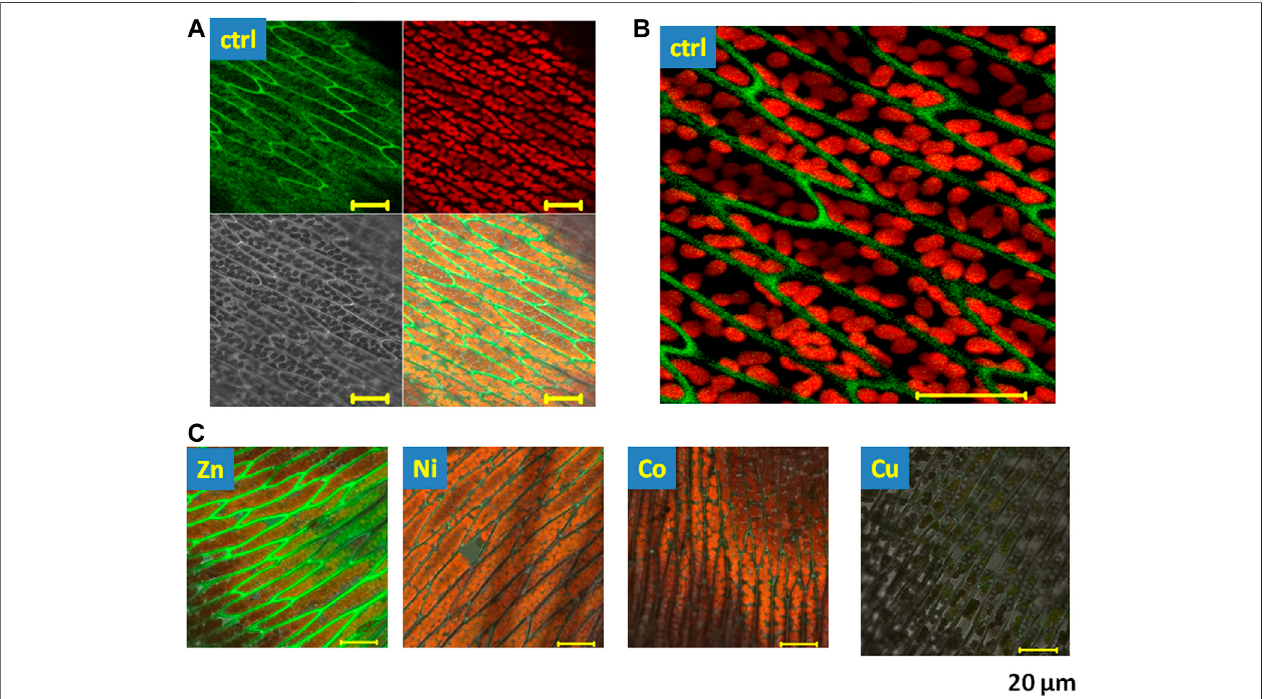
FIGURE 1 | Fluorescence microscopy images of endogenous fl uorescence of Fontinalis antipyretica in control conditions and in the presence of heavy metal NPs. (A) Images recorded by laser scanning confocal microscopy in control conditions, excitation 450 nm. Green fl uorescence channel 1) emission 550 – 550 nm, red fl uorescencechannel2)emission650 – 710 nm,greychannel3)transmissionimage,mixedchannel4)overlayofchannels1 – 3. (B) Ampli fi edsectionoftheoverlaidgreen and red fl uorescence image, (C) the overlay of all channels in the presence of the tested heavy metal NPs (Zn, Ni, Co, and Cu); scale 20 μ m.